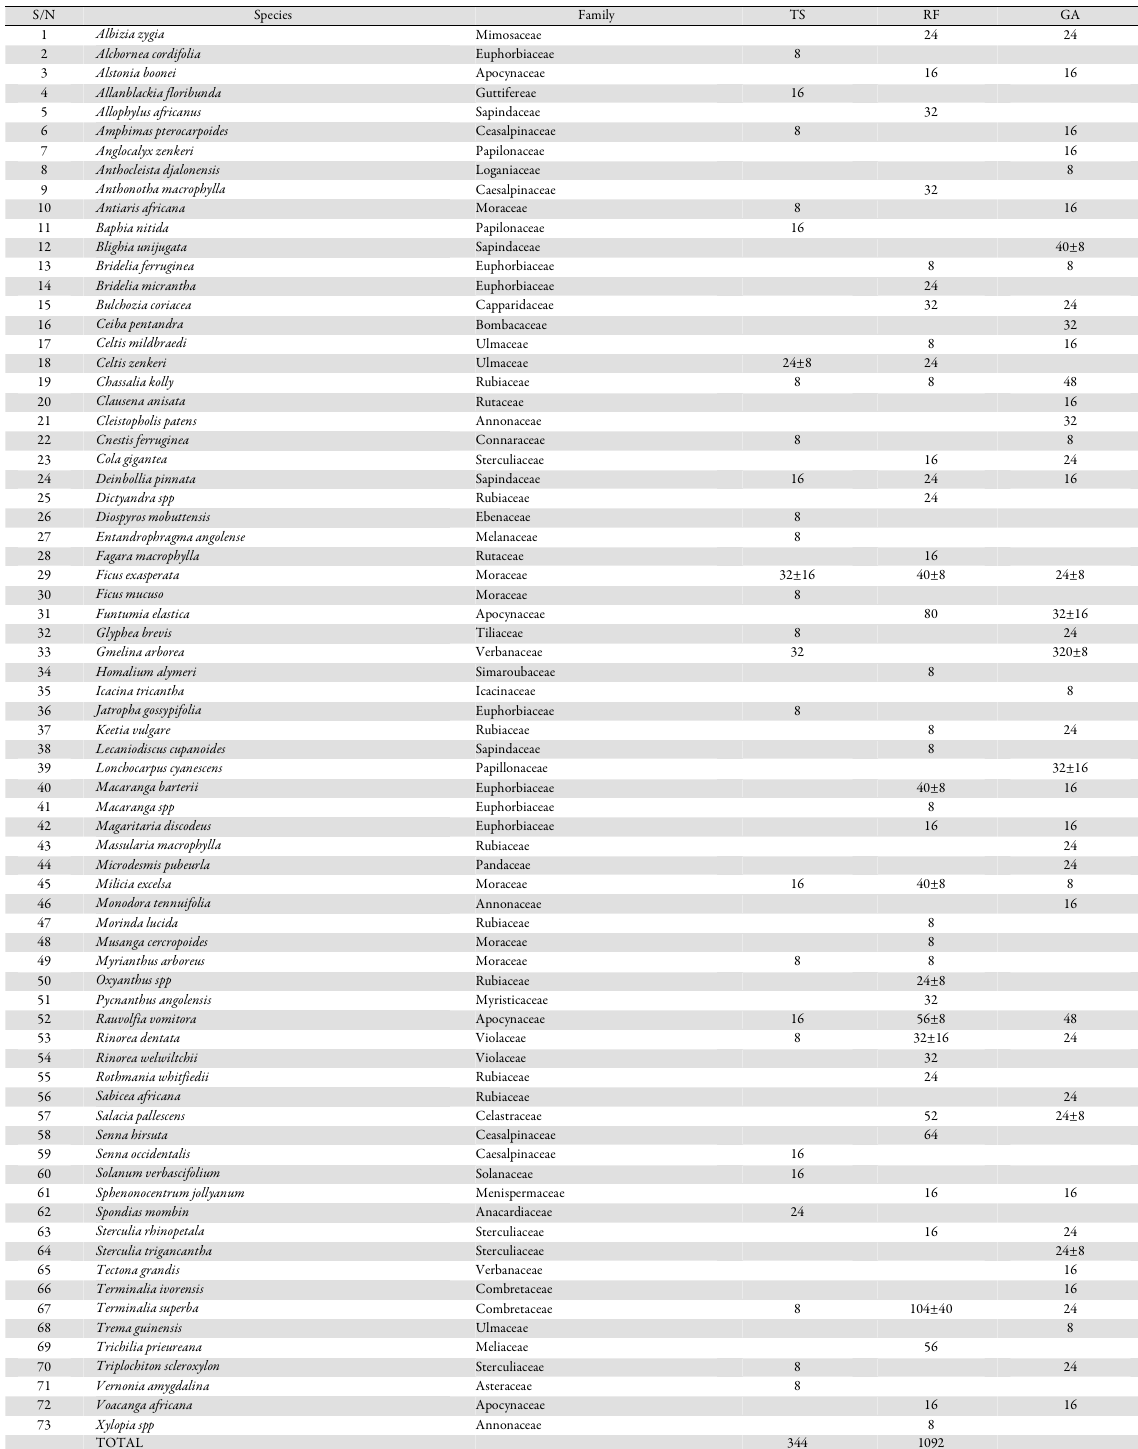
Tab. 2. Mean density of woody species (per hectare) in the three sites of the Shasha forest reserve